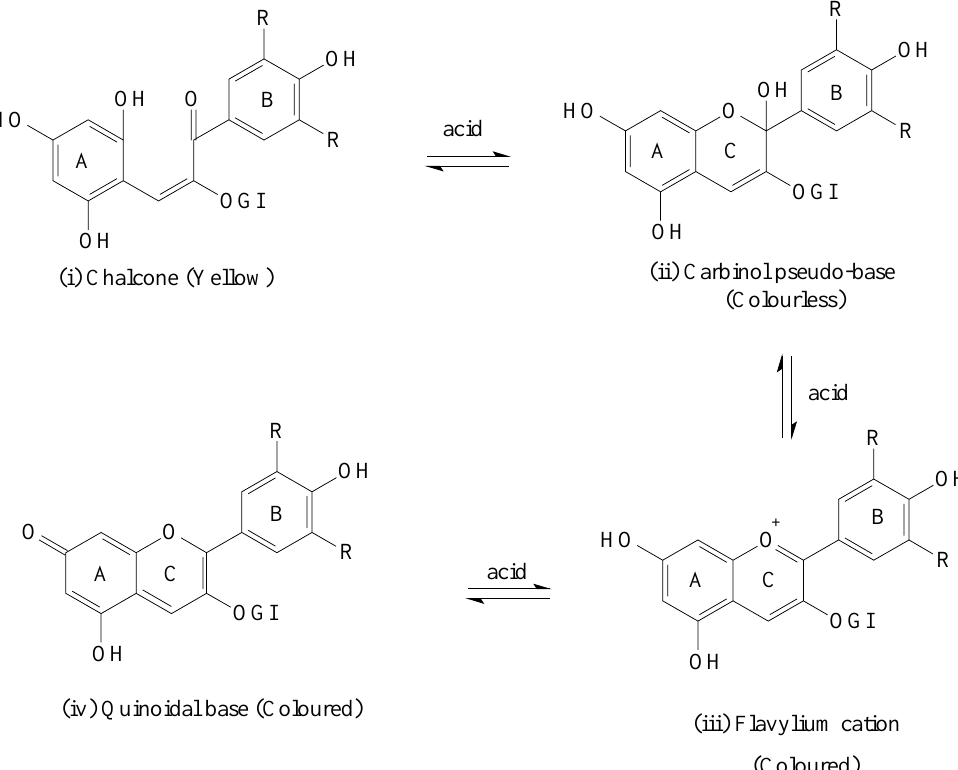
(iii) Flavylium cation